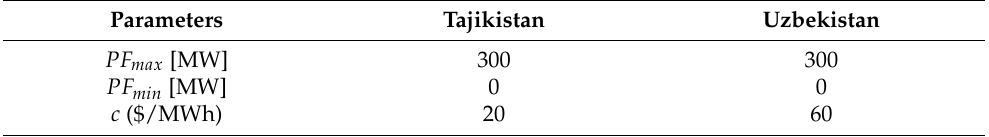
Table 3. Import powers parameters